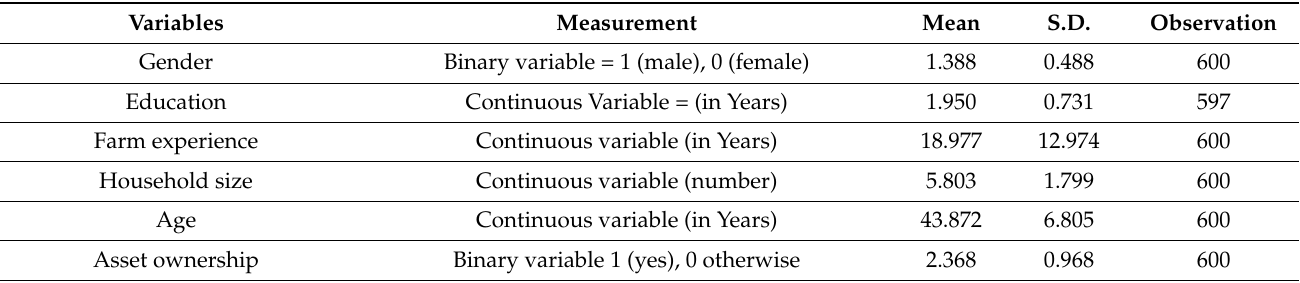
Table 2. Variable names and